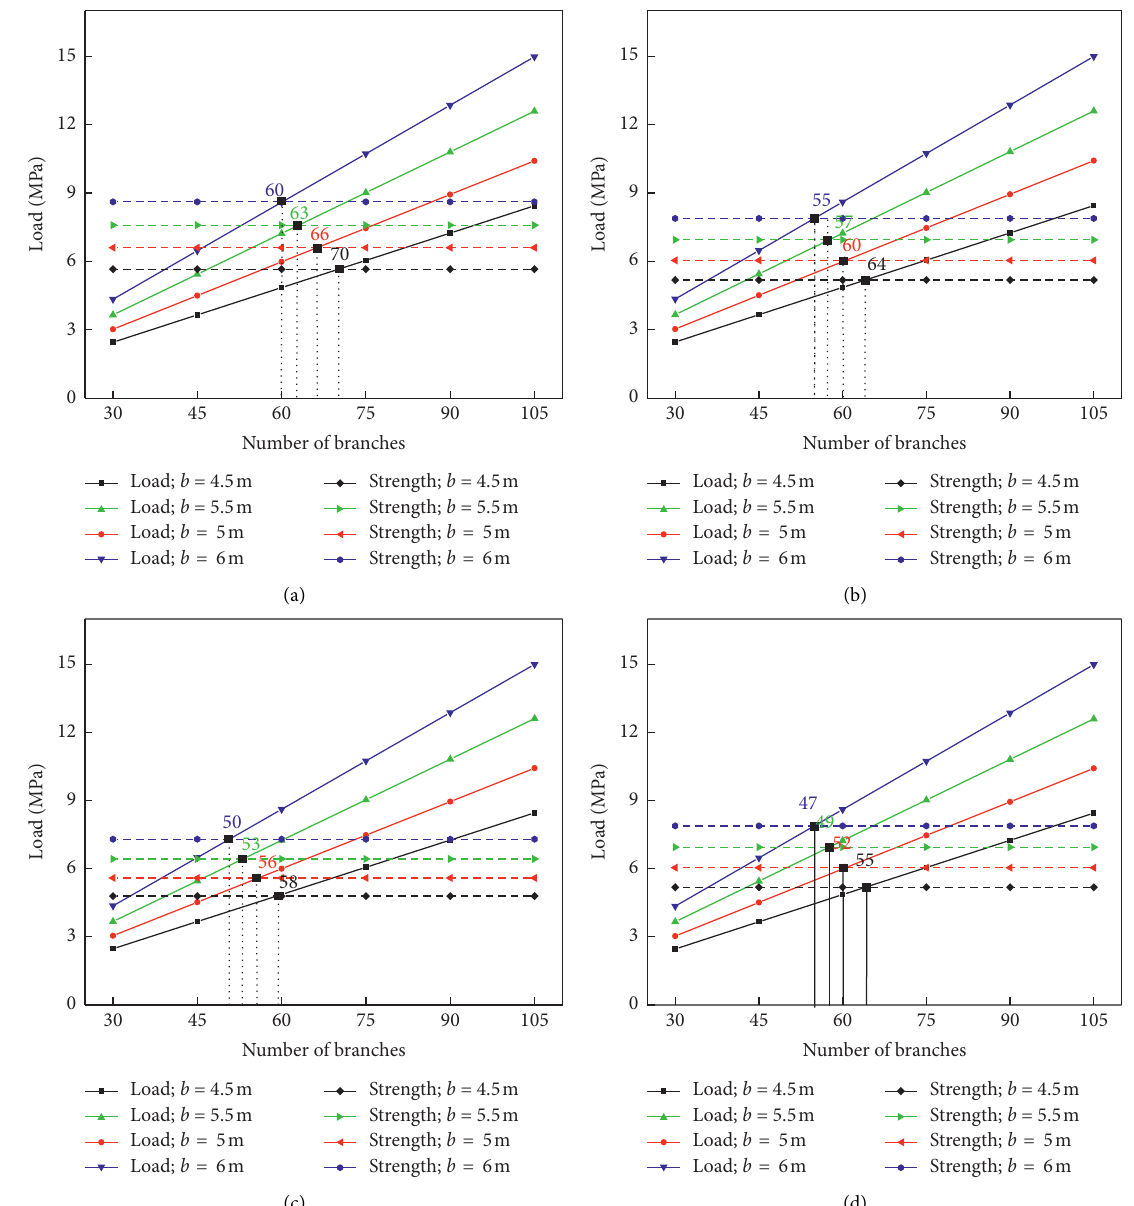
Figure 5: Coal pillar strength and coal pillar load. (a) h � 3.5 m. (b) h � 4m. (c) h � 4.5m. (d) h � 5